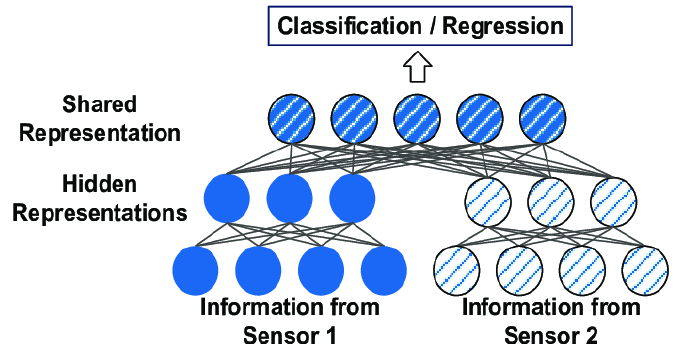
Figure 1. A baseline of multimodal fusion learning.